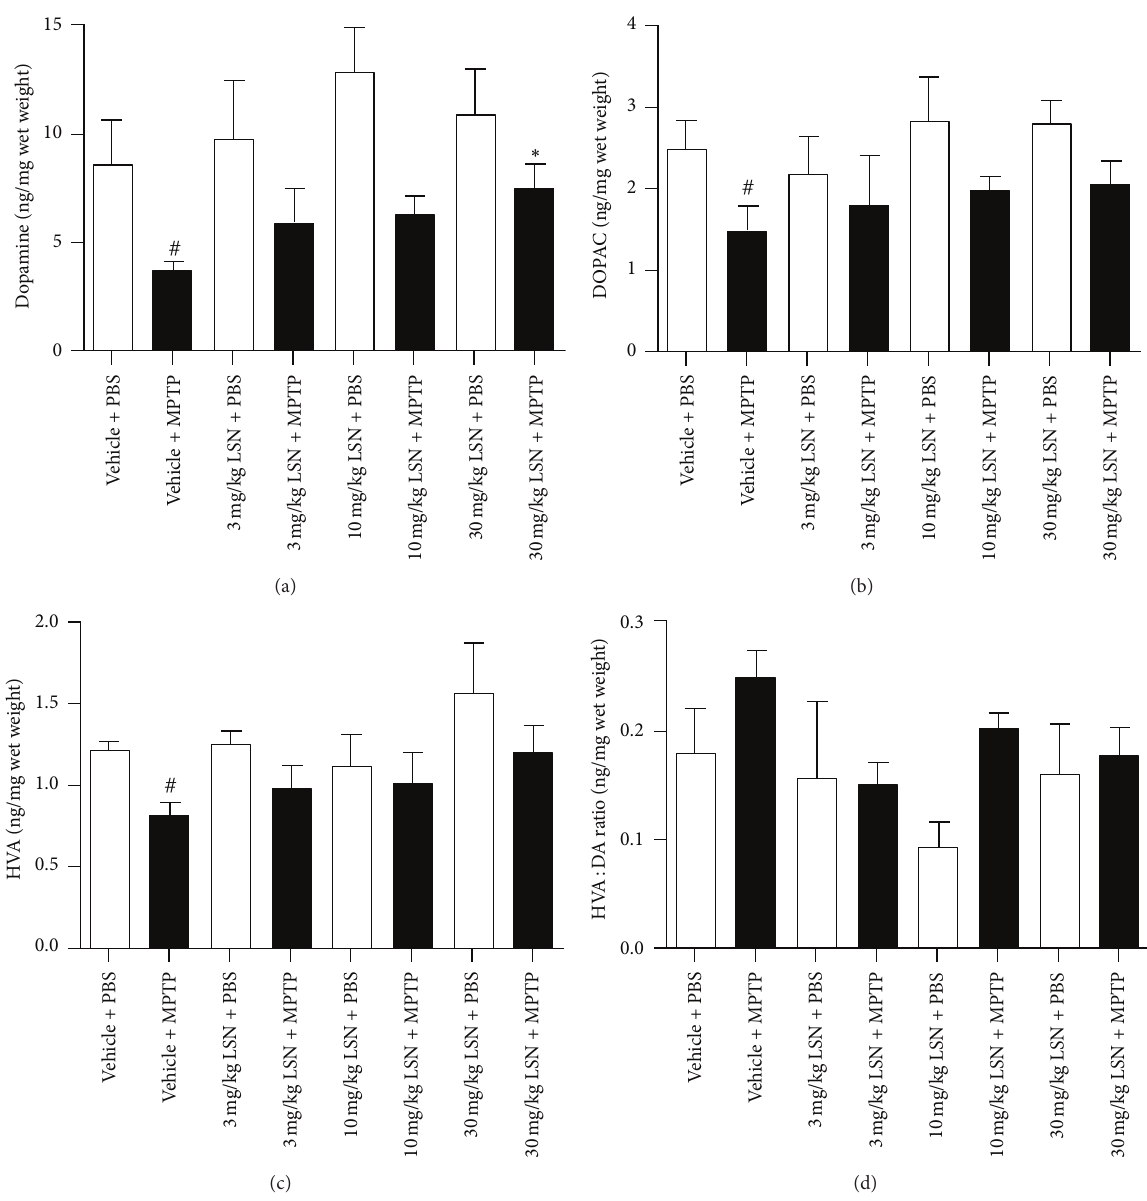
Figure 3: LSN862 (LSN) induced protection of striatal catecholamines against MPTP dopaminergic loss. HPLC analysis of striatal cate- cholamine levels was performed in mice tissues obtained 21 days after treatment with MPTP or PBS and LSN or vehicle (mean ± SEM). (mean ± SEM; 𝑛 = 4 – 7 per group). ANOVA (Fisher’s LSD post hoc). (a) Dopamine: # 𝑃 < 0.05 (vehicle + PBS versus vehicle + MPTP), ∗ 𝑃 < 0.05 (vehicle + MPTP versus 30mg/kg LSN + MPTP). (b) DOPAC: # 𝑃 < 0.05 (vehicle + PBS versus vehicle + MPTP). (c) HVA: # 𝑃 < 0.05 (vehicle + PBS versus vehicle + MPTP). (d) DOPAC/HVA ratio.